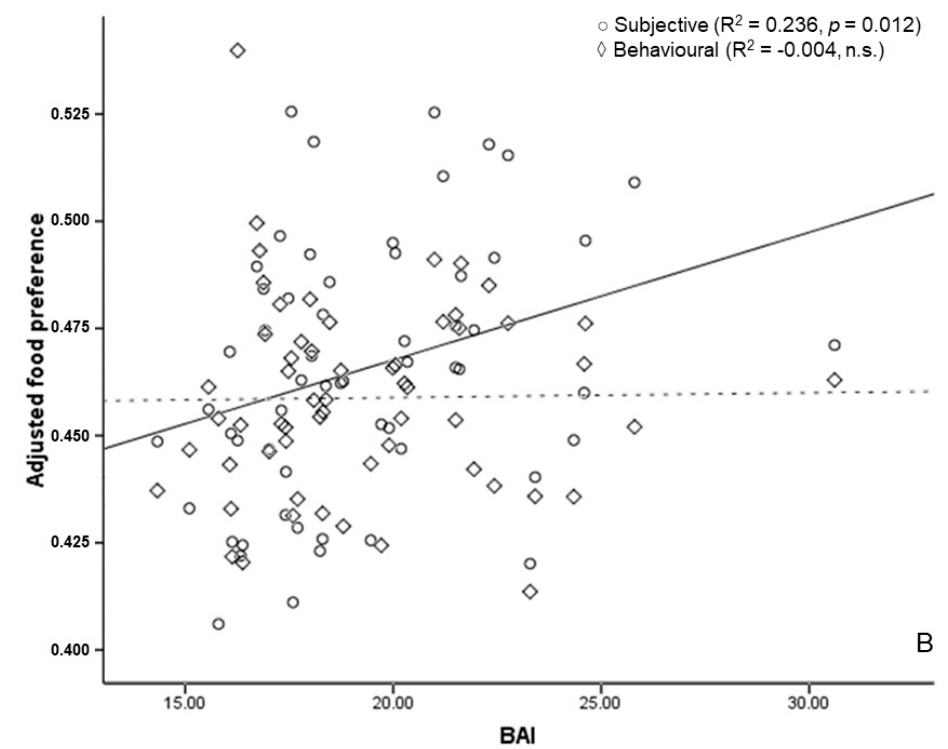
Figure 2. Food preference and anthropometric markers of cardiovascular risk in men and women. Adjusted predicted value of food preference for Waist-to-Hip Ratio ( A ) and Body Adiposity Index ( B ) in total sample. The straight line represents the line of best fit of the subjective category. The dotted line represents the line of best fit of the behavioural category.